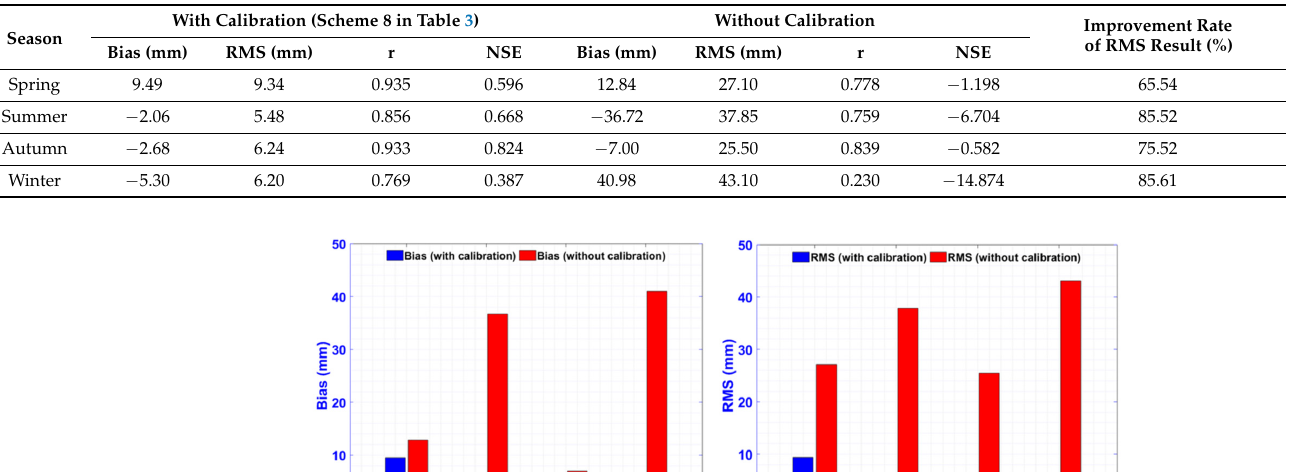
Table 4. Comparison of the average seasonal differences between potential evapotranspiration (PET) time series estimated from the Penman–Monteith (PM) and Thornthwaite (TH) models at the three pairs of stations under the conditions of with and without calibration over the period 2008–2019.